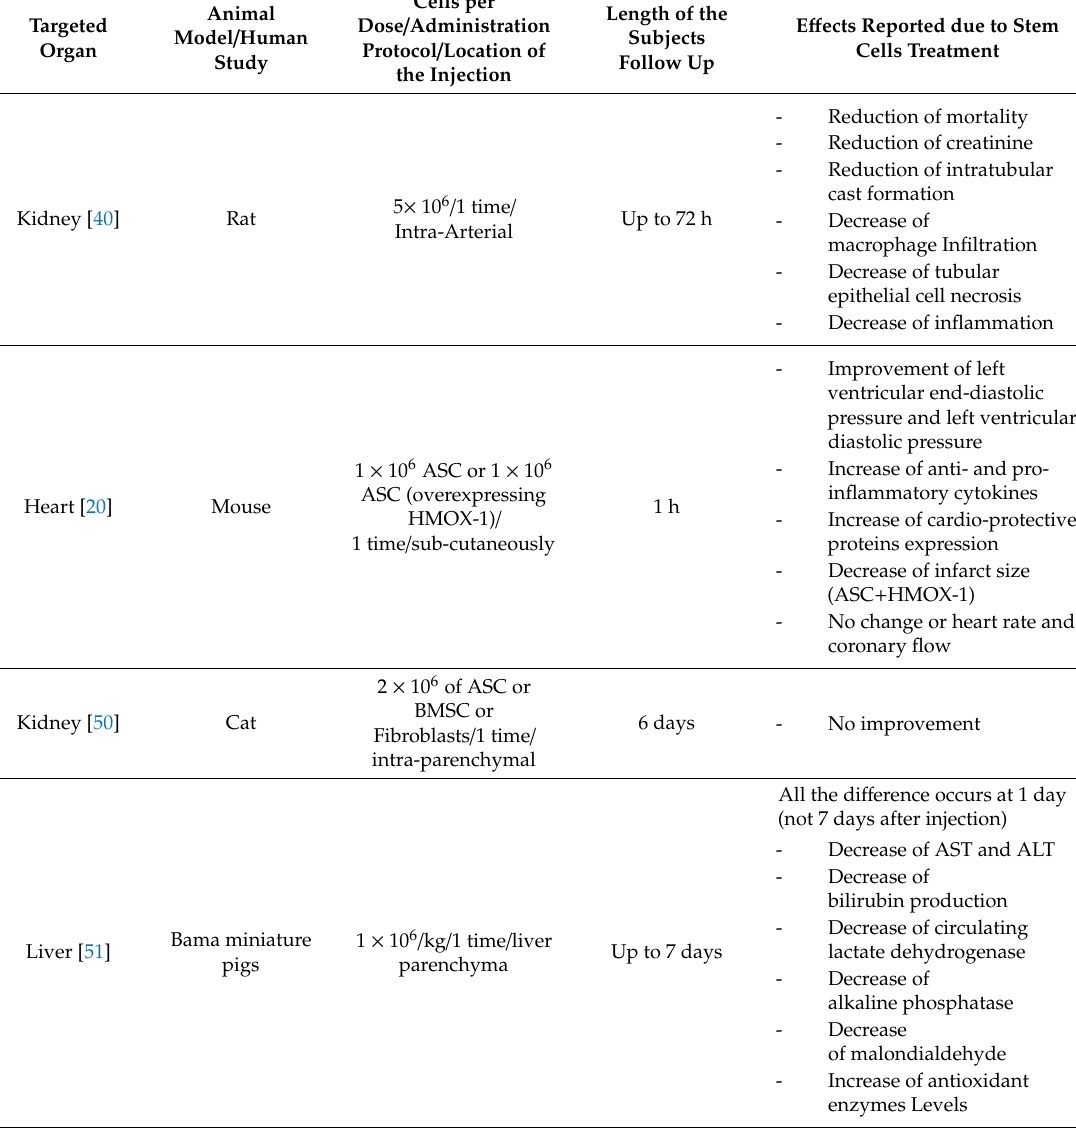
Table 2. Adipose-Derived Stem